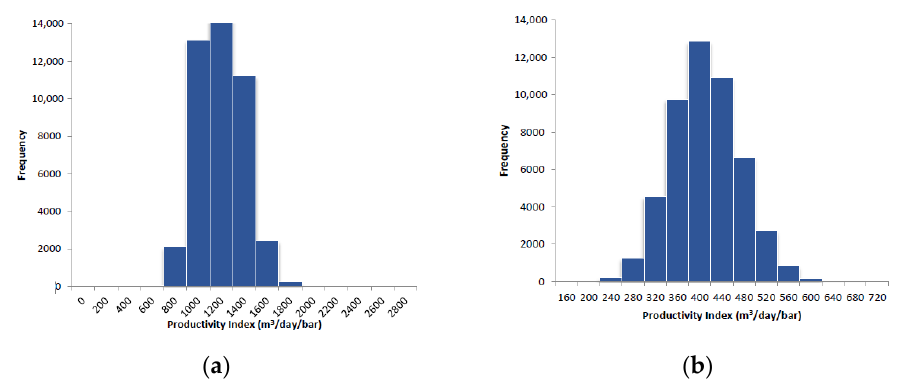
Figure 9. Productivity index distribution—Drava ( a ) and Sava ( b ) Depression—pre-rift phase. Table 3. Heat-in-place probability distribution of analysed well doublets.